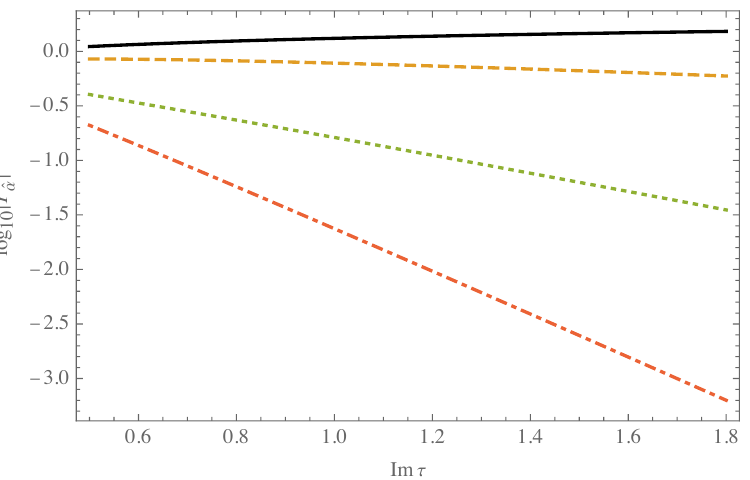
for Re τ = 0 . 1 . The black solid, b α α = 0 , 1 , 2 and 3 , respectively. b α b